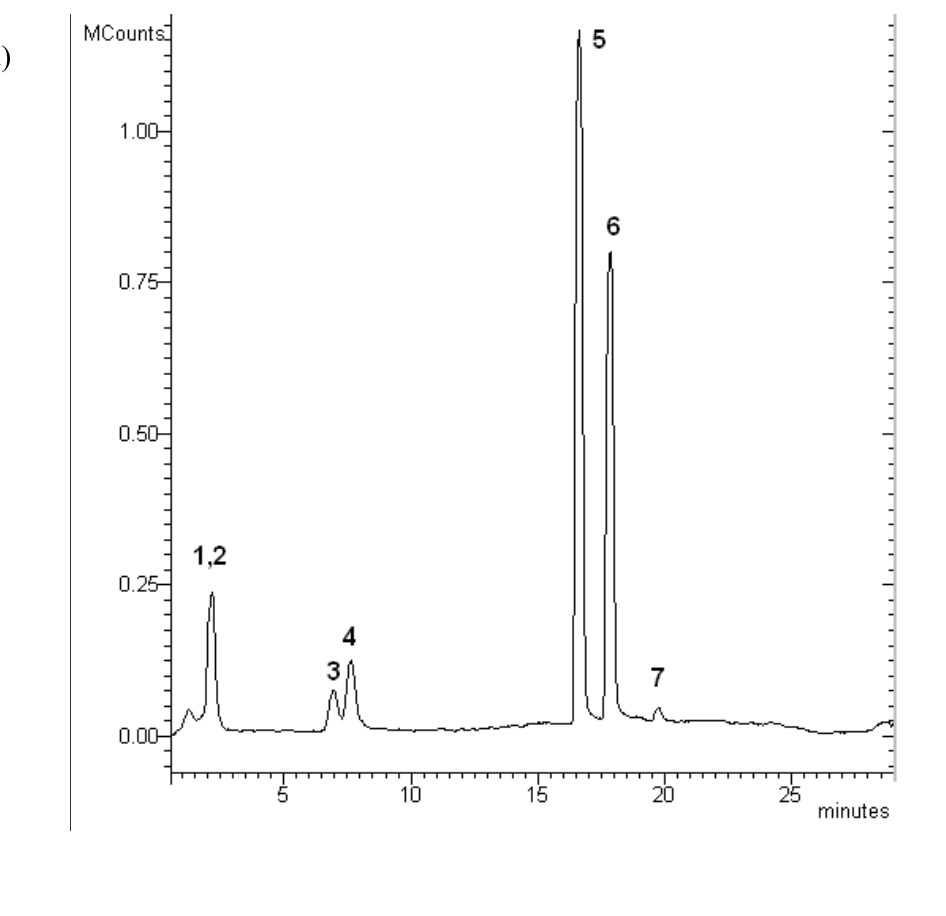
Figure 1. ( a ) Total ion current of pharmaceutical compounds in a standard mixture with LC-MS/MS detection: 1-Atenolol; 2-Acetaminophen; 3-Norfloxacin;